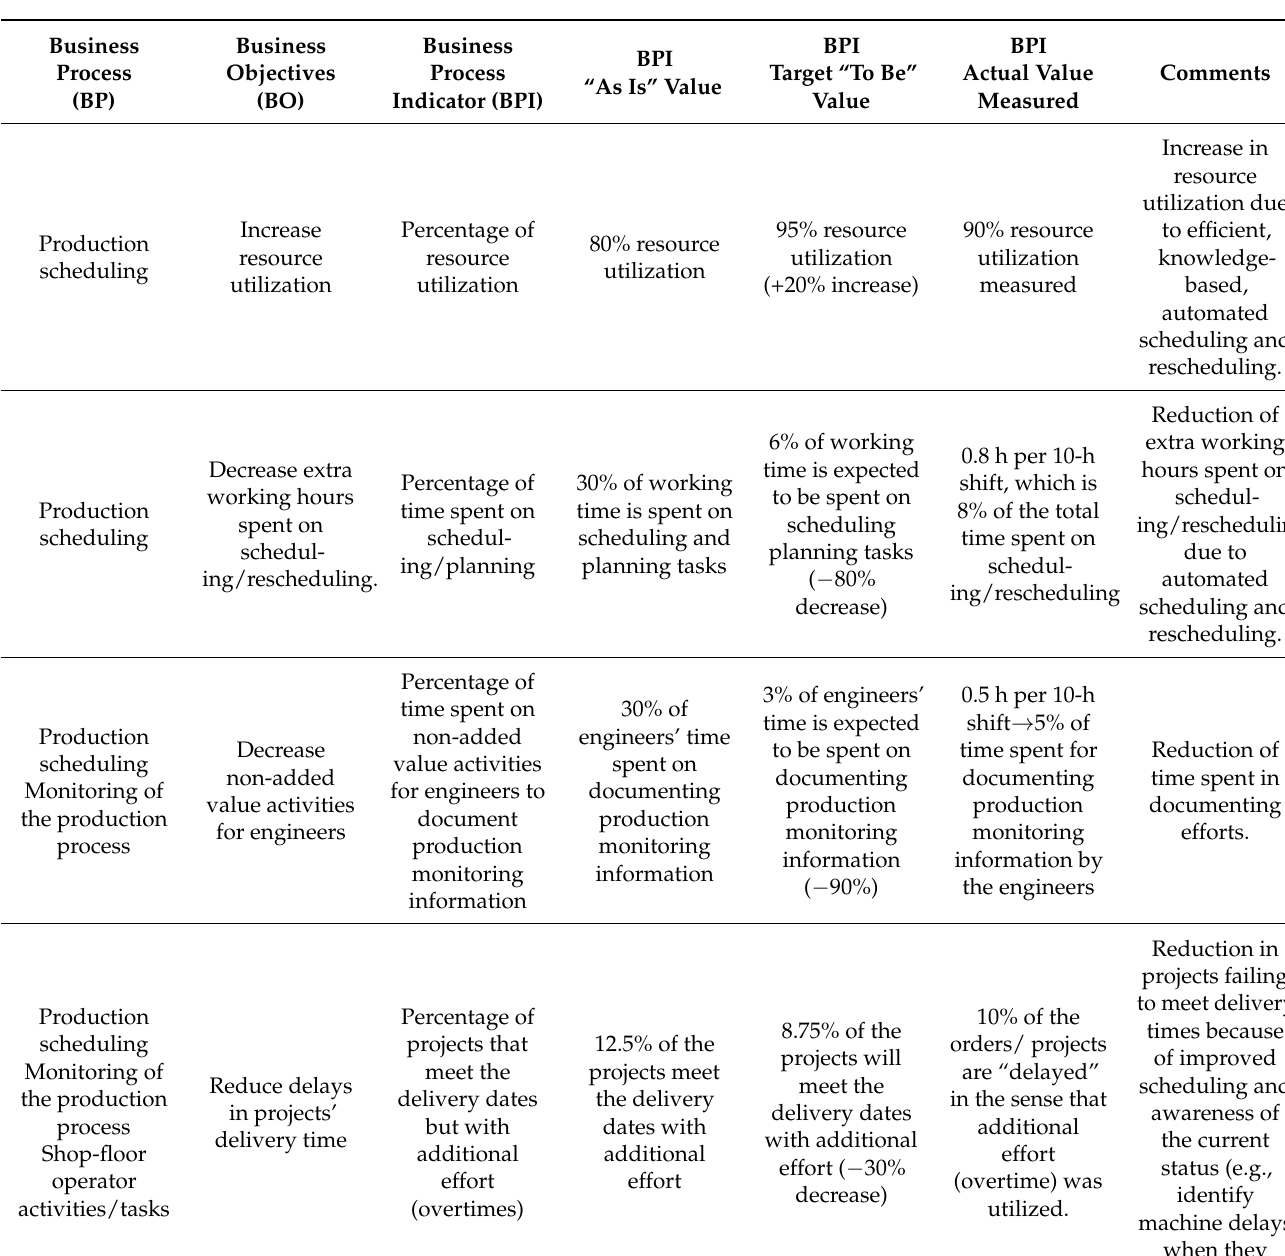
Table 3. Business Performance Indicators